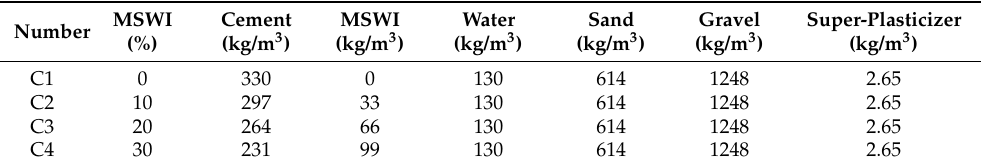
Table 4. Mix proportion of MSWI